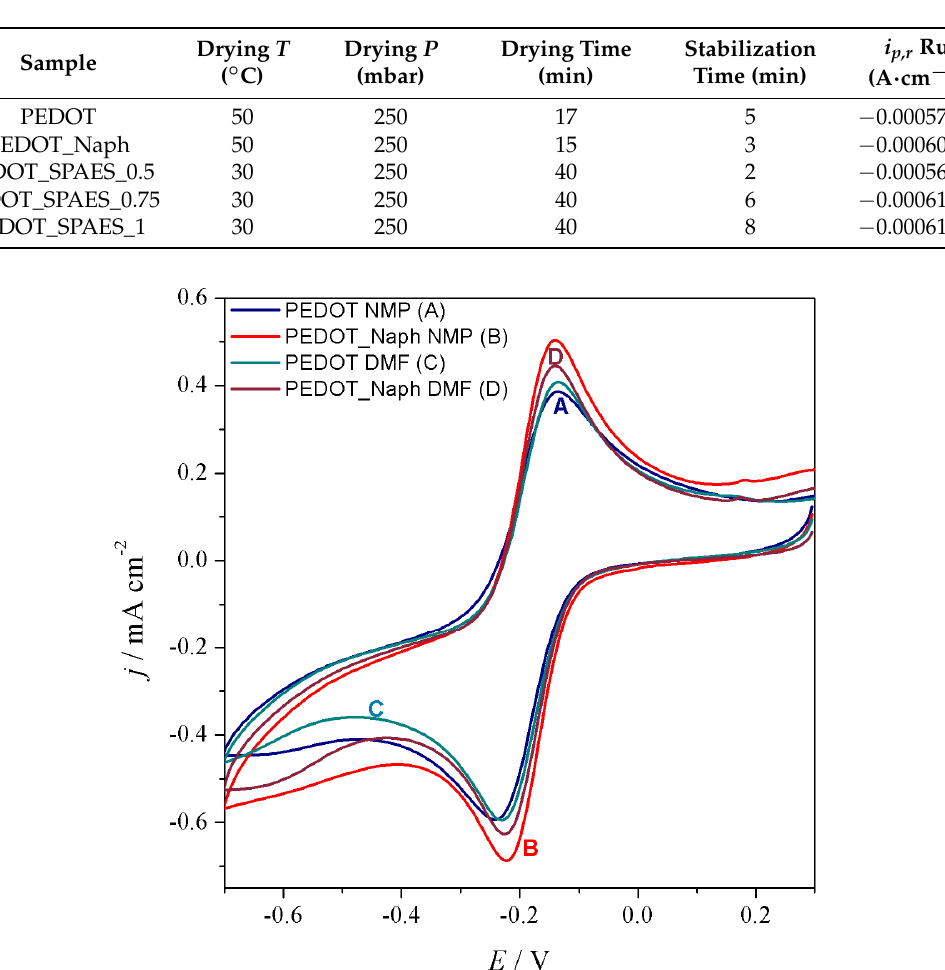
Table A1. Drying temperature, pressure, and time of PEDOTs’, PEDOT_Naphs’, and PEDOT_SPAESs’ polymeric solutions in DMF, and the stabilization time and current of the corresponding modified electrode.